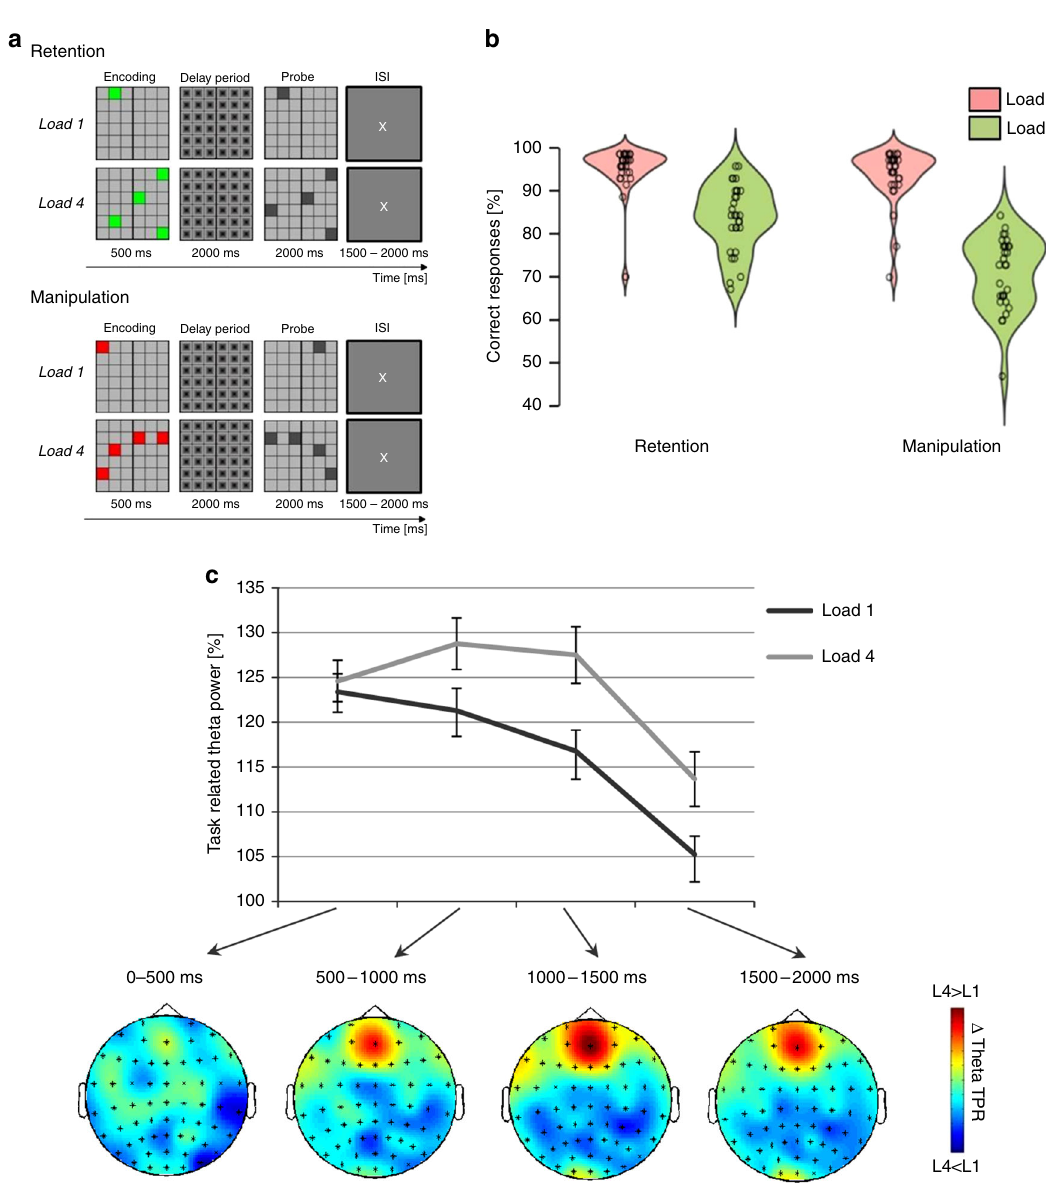
Fig. 1 Experimental paradigm, behavioural results and FM-theta amplitude. a Schematic depiction of single trials from experiment 1 with conditions ” retention “ and ” manipulation “ and variation in memory load (load 1 vs. load 4). In the retention condition spatial locations of one or four items had to be retained for 2000ms and then compared to a probe. In the manipulation conditions spatial locations of items had to be mentally mirrored around the vertical gap in the grid, retained in memory and compared to the probe. b Accuracy rates (in percent) for the four conditions from experiment 1. Red violin elements represent load 1 conditions, green violin elements indicate load 4. c Task-related FM-theta amplitude increase during the delay period at electrode AFz. Values beyond 100% indicate increased amplitude compared to baseline. Error bars represent standard error of mean. Brain maps show the topographical distribution of FM-theta activity difference between load 4 and load parietal gamma burst was nested shortly prior to the peak of the statistically compared using Wilcoxon-tests. Only for the right FM-theta cycle, whereas in the hardest condition (manipulation temporo-parietal cluster real data showed signi fi cantly stronger load 4) this high-frequency activity burst occurred slightly before gamma amplitude modulation by FM-theta phase (as indicated the trough of the FM-theta period. Thus, the amount of cognitive by higher maxima in the cross-correlograms) compared to shifted control required for the task determined the phase of FM-theta to data (all Z > − 2.03, all p < .022, FDR-corrected, one-tailed). Interestingly, FM-theta phase associated with maximal right temporo-parietal gamma amplitude differed between conditions: with increasing task dif fi culty a precession of phase to gamma amplitude coupling towards the trough of the theta cycle was observed (Fig. 2a; results from a repeated-measures ANOVA: signi fi cant main effect or interaction (all Fs 1/24 < 1.6, all ps signi fi cant interaction between LOAD, CONDITION, and FM- > .21).]. This suggests a dynamic and effort-related modulation of THETA PHASE: F 9/216 = 2.65, p = .033, Huynh-Feldt corrected). In the easiest condition (retention load 1) the right temporo- the interaction between prefrontal and temporo-parietal regions